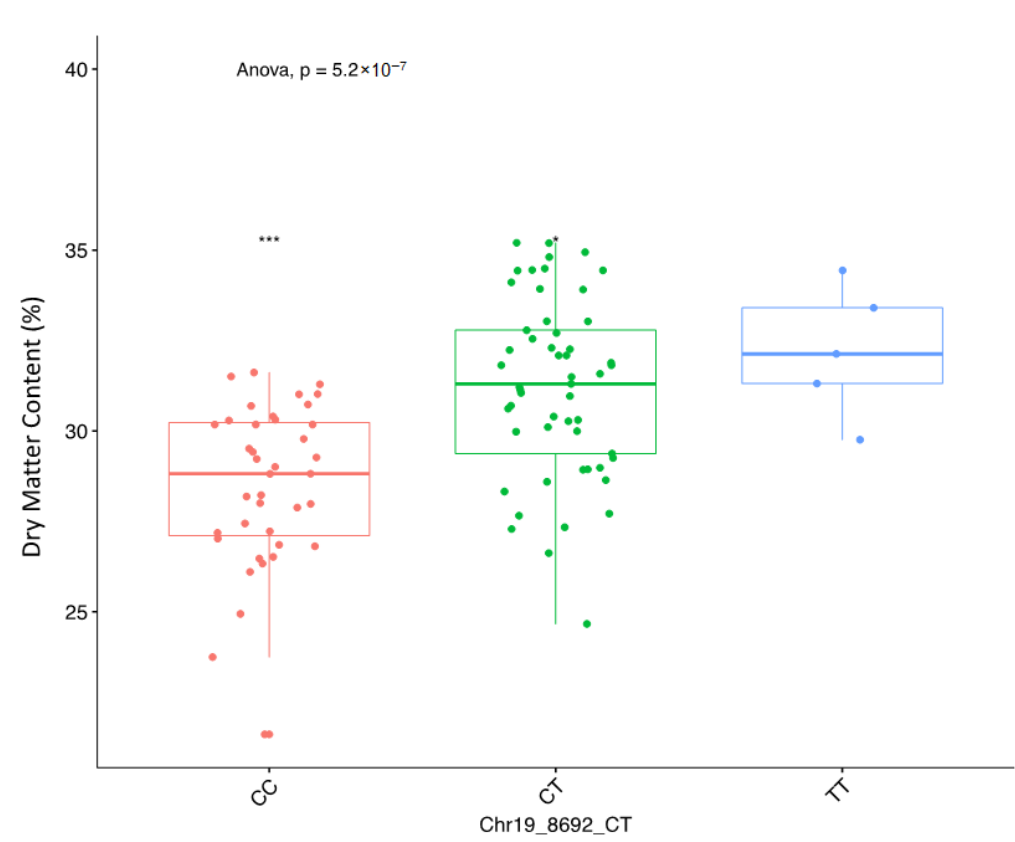
Figure 3. Boxplots showing the effect of the significant markers associated with tuber DMC on chromosome 6 with two SNPs: ( a ) Chr6_59775 and ( b ) Chr6_615325. The letters on the X axis represent allele variants (AA, GA, and GG); significant codes: * = 0.05 and p represents the analysis of variance probability value associated with the variation across variants.